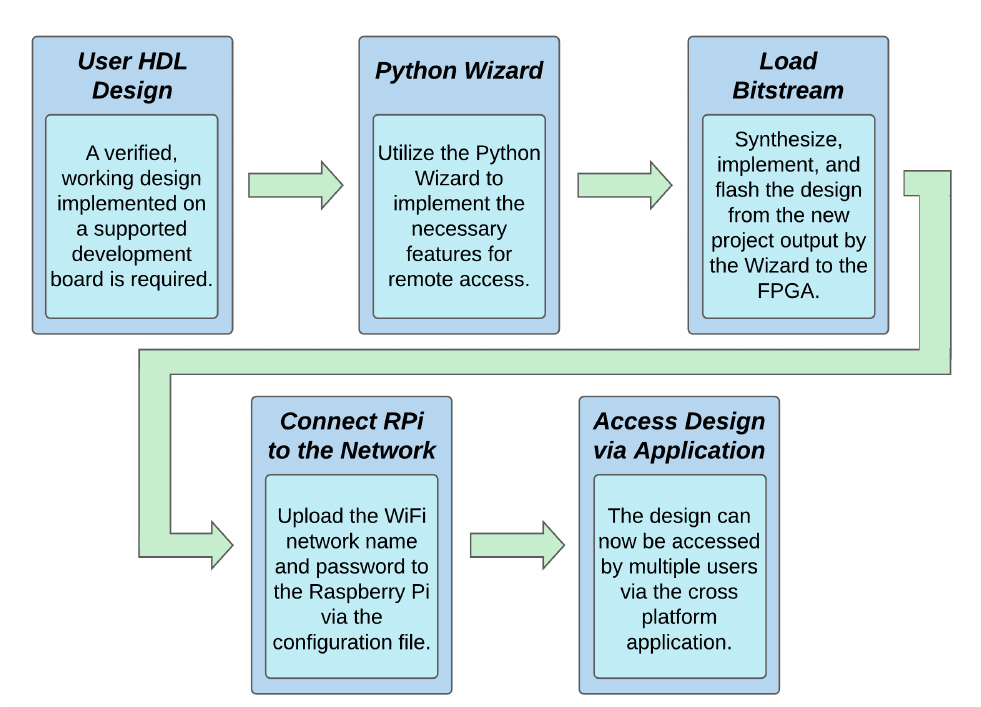
Figure 1. The required design flow for implementing remote access into a